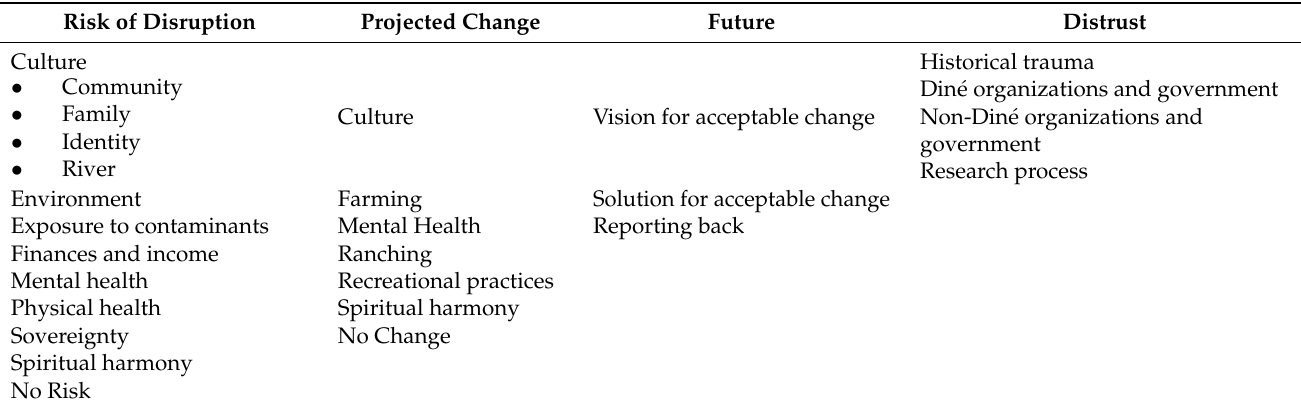
Table 2. Themes and sub-themes derived from analysis of 12 focus groups held in Shiprock, NM, Upper Fruitland, NM and Aneth, UT in May and June 2016.